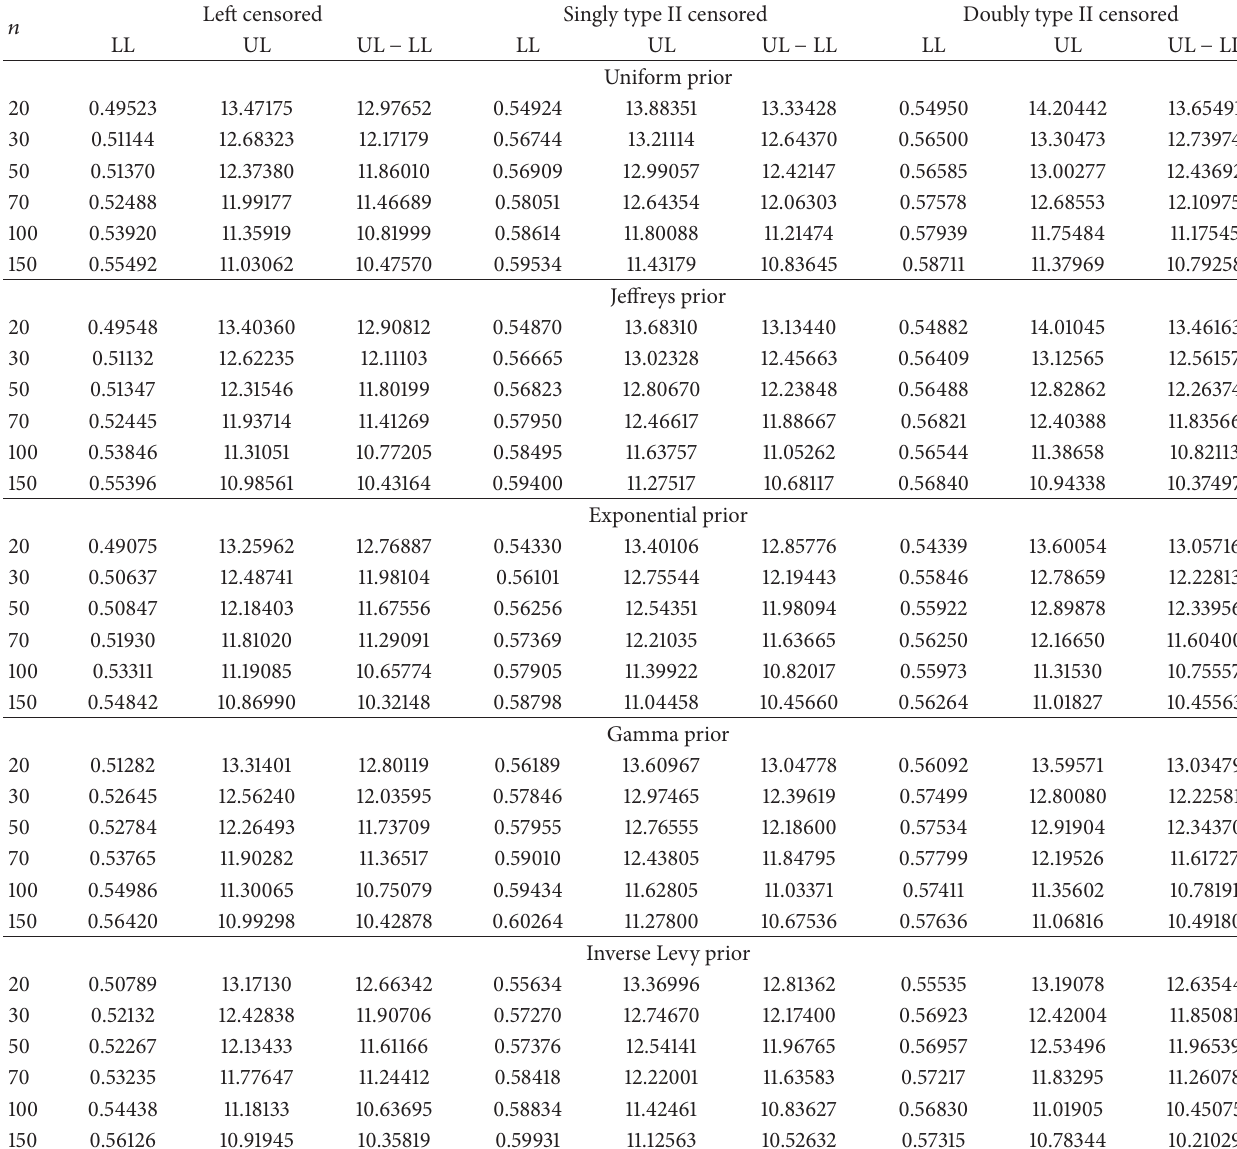
Table 7: 95% posterior predictive intervals under different priors and censoring techniques for Ψ = 2